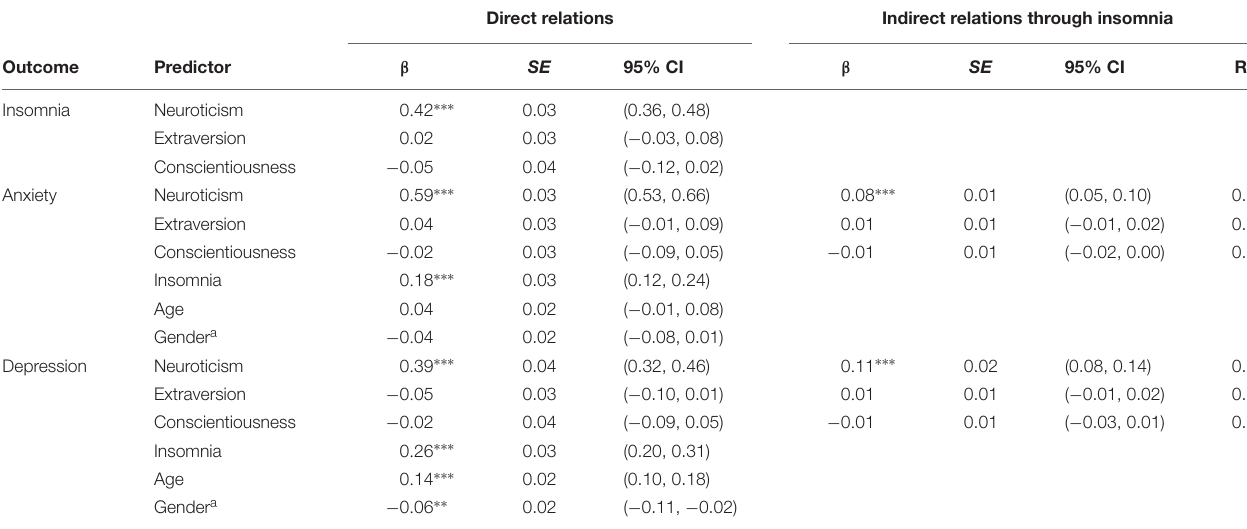
TABLE 2 | Standardized path coefficients in the structural model showing direct and indirect relationships between personality, insomnia, anxiety, and depression ( N = 2962). Direct relations Indirect relations through